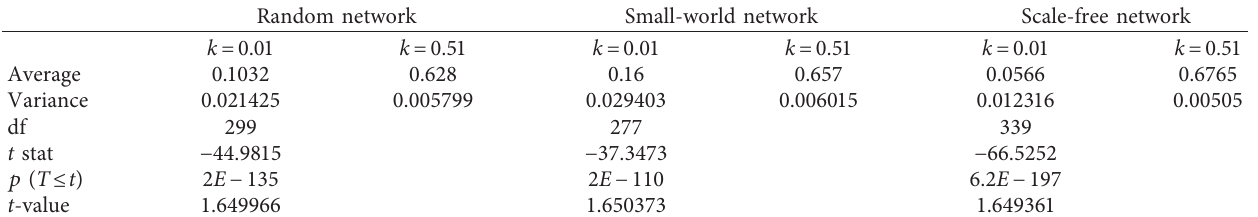
Table 4: The t -test results of